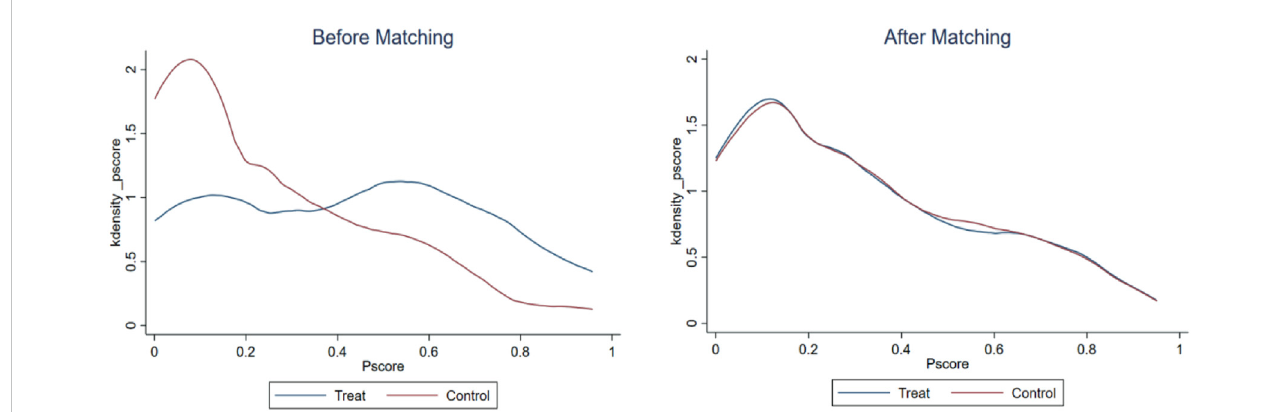
Difference-in- difference